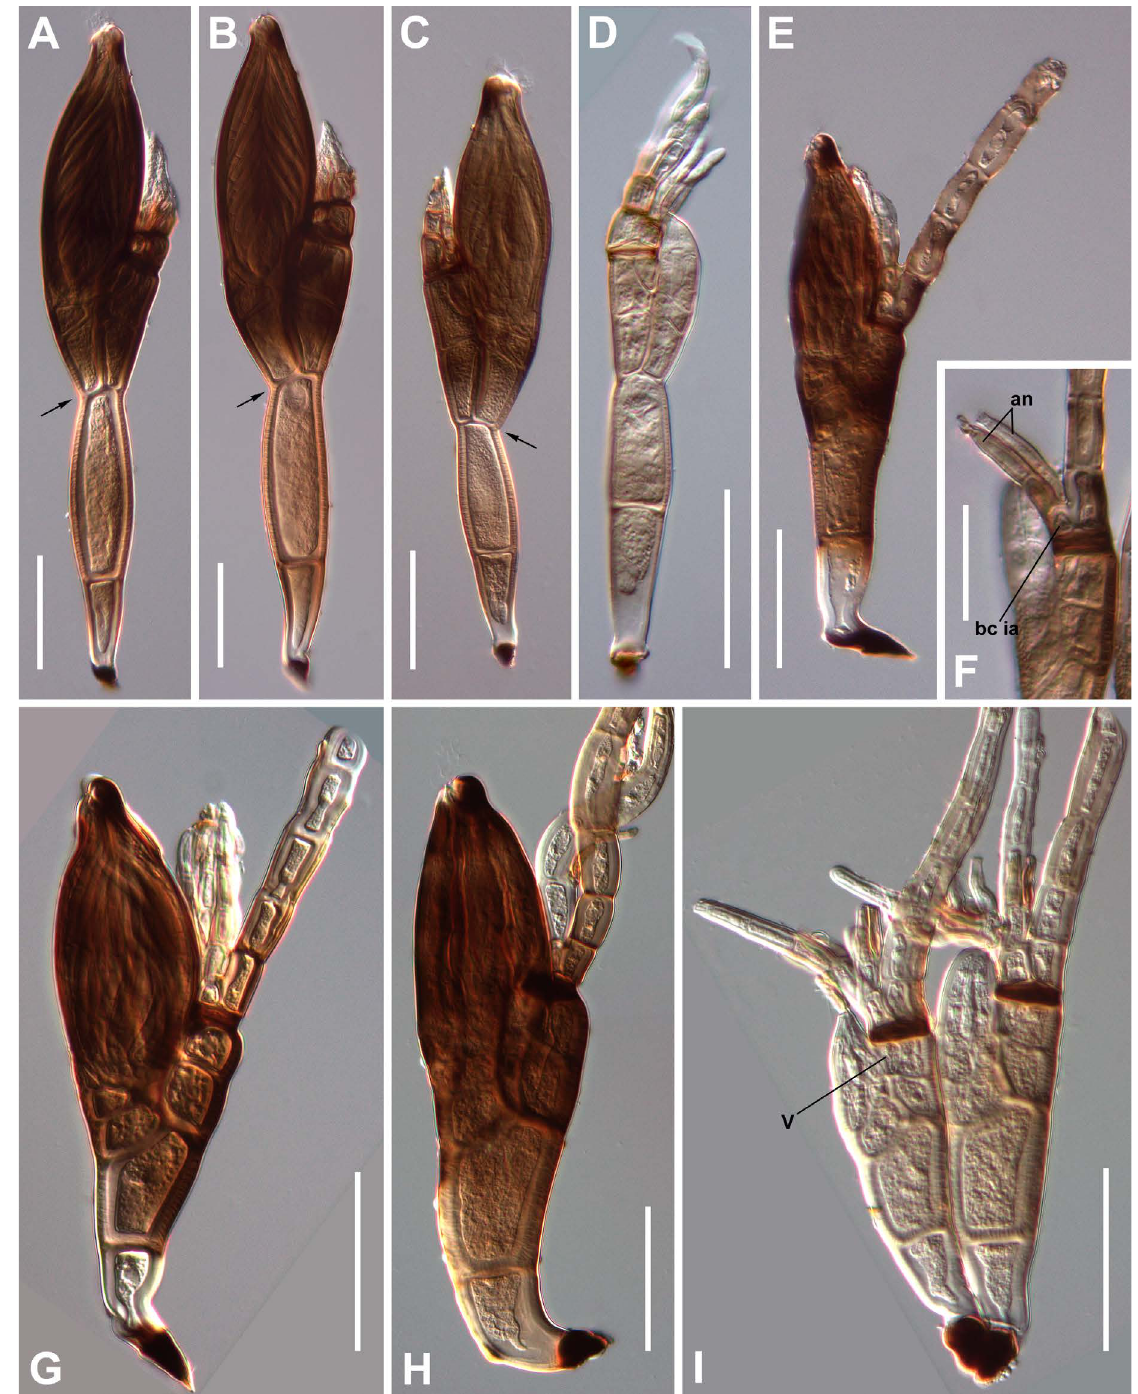
Fig. 38. Laboulbenia spp. A – D . L. murmanica Huldén. A – C . Mature thalli showing constriction at septum II–VI/III (arrows). D . Immature thallus showing undamaged appendage. – E – G . L. notiophili Cépède & F.Picard. E , G . Mature thalli. F . Inner appendage in detail showing antheridia (an) and basal cell of inner appendage (bc ia). – H – I . L. olisthopi Speg. H . Mature thallus. I . Two immature thalli with labelled cell V. Scale bars: A–E, G–I = 50 µm; F = 25 µm. Photographs from slides ZMUC